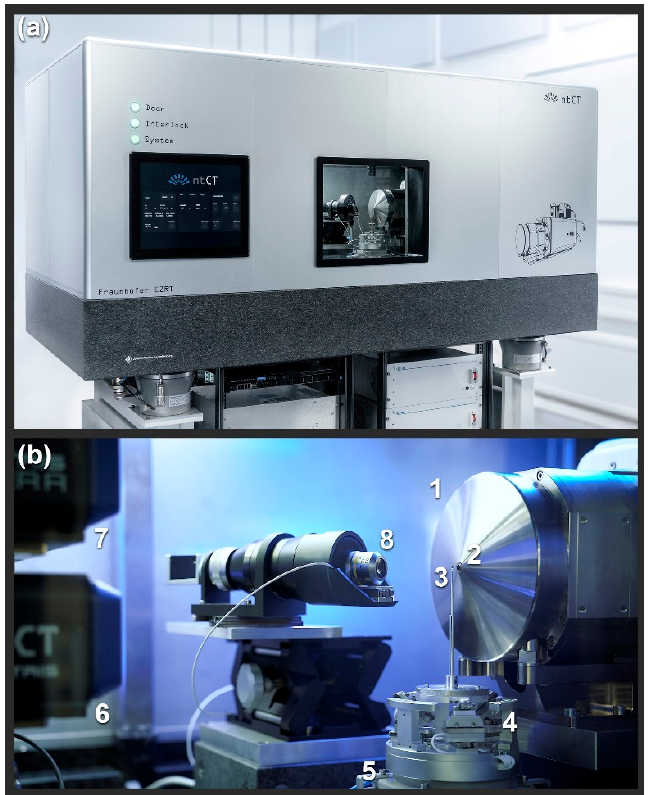
Figure 1. Image and description of the main components of the used system. ( a ) Exterior view of the system with a temperature-controlled lead booth and air-bearing granite for vibration damping. ( b ) Inside view into the device with: 1. nano focus X-ray source, 2. exit window and at the same time tungsten transmission target on a diamond substrate, 3. sample mounted on a needle-shaped holder, 4. 6-DOF hexapod made of piezo linear axes for fine adjustment of the sample on the rotation axis, 5. air-bearing rotary stage (and in the picture not visible below three further linear axes for positioning of the sample holder), 6. DECTRIS EIGER2 R CdTe detector on 3 linear axes, 7. DECTRIS detector with SI sensor, and 8. optical microscope to support the sample adjustment.